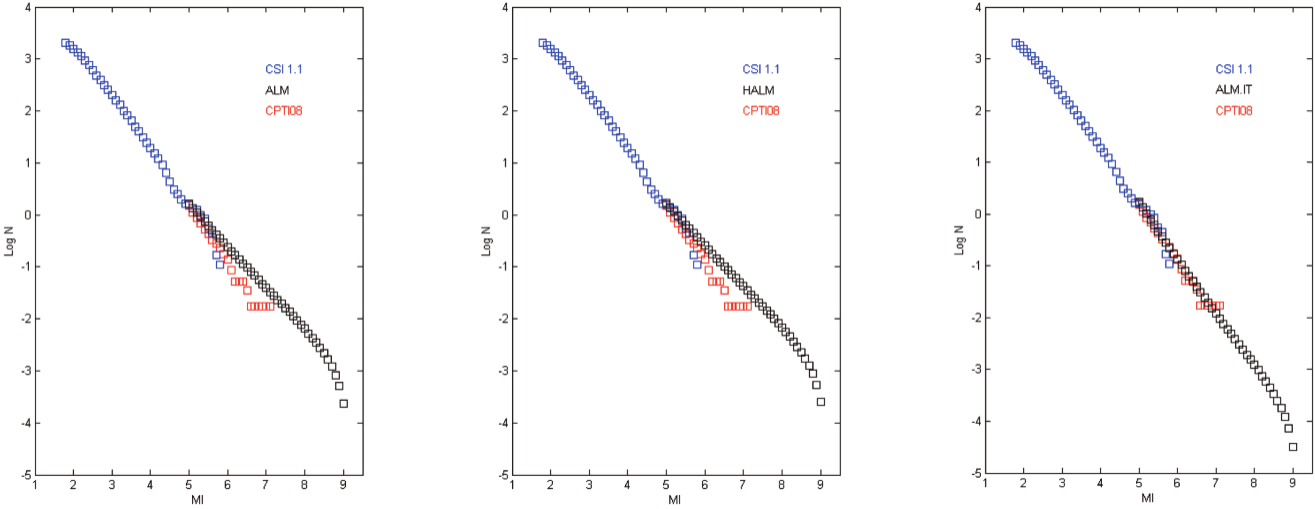
Figure 8. Annual frequency-magnitude distributions of the forecast rates for the three models (black squares, ALM, HALM, ALM.IT) against the observed rates: CSI 1.1 [Castello et al. 2006] from 1983 to 2002 (blue squares); the CPTI08 (http://eu.cseptesting.org/; red